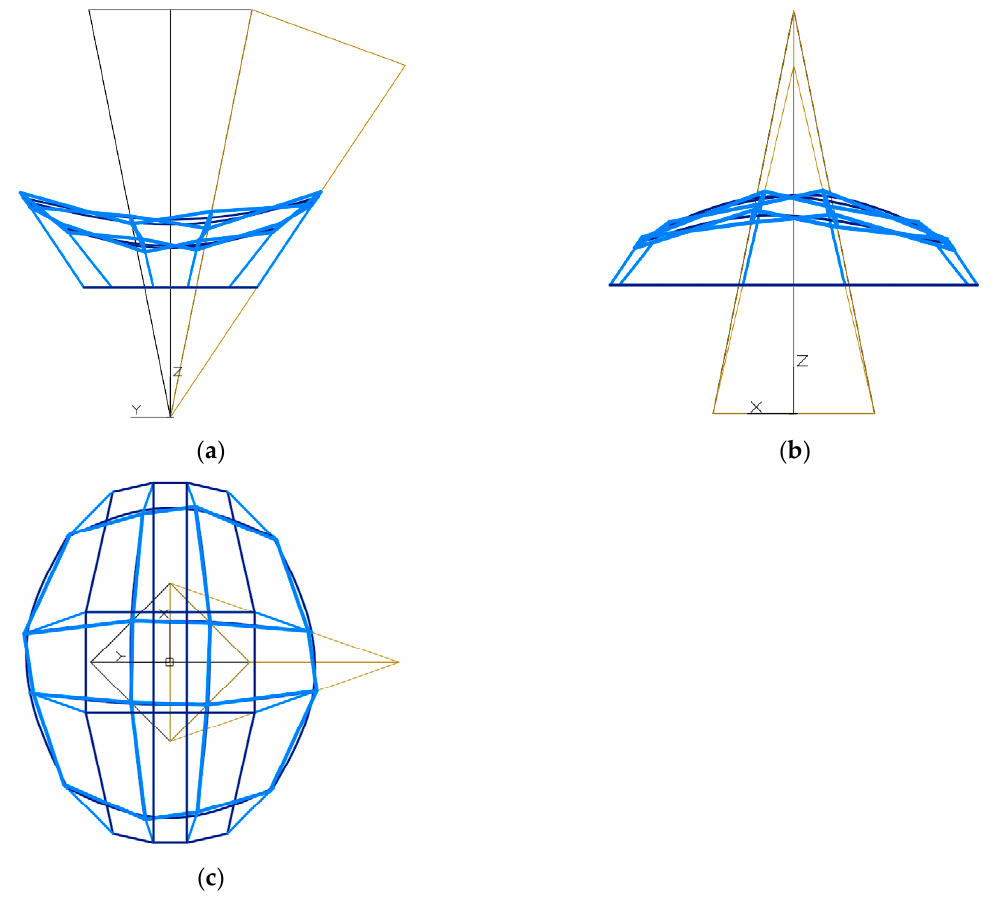
Figure 10. The designed reference network Γ , the first eaves network B v , and the first complex building structure Σ : ( a ) the front view, ( b ) the back view, ( c ) the top view. The following meshes of the Γ 1 , B v 1 nets and the reference surface are created in the same way. Alternatively, some vertices must be adopted at the positions of the corresponding vertices belonging to the previously constructed meshes.